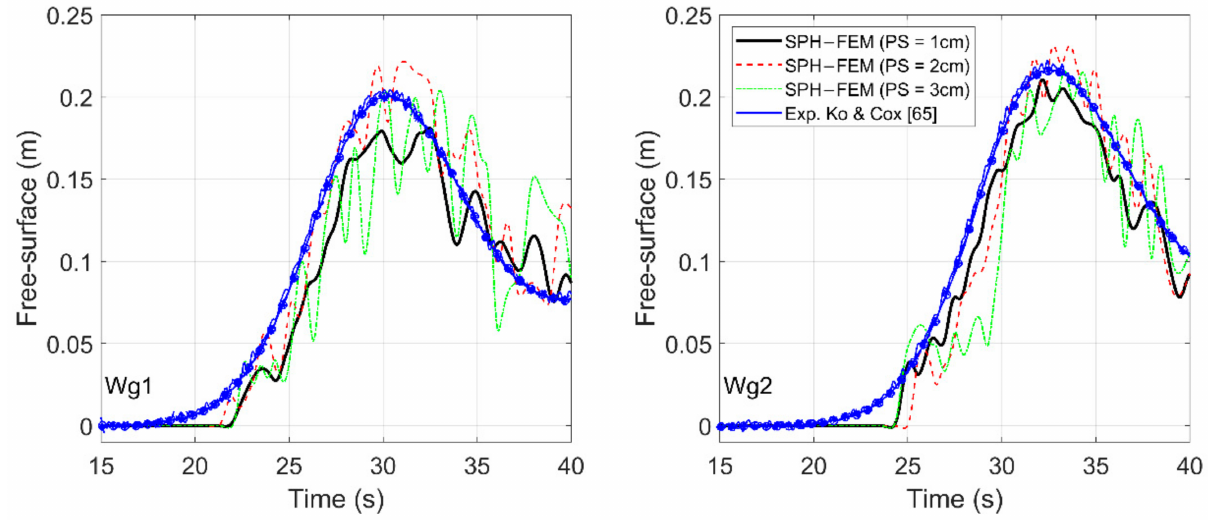
Figure A1. Variation of the free surface at different locations along the flume. Experimental [65] and numerical results for three particle sizes, for h 1 = 2.496 m and T erf = 30 s.